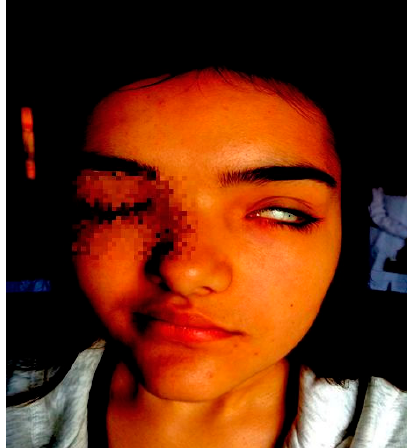
Figure 1. Right ‐ sided deviation of the labial commissure, obliteration of the left nasolabial fold, and incomplete closure of the left eye (Patient 1).